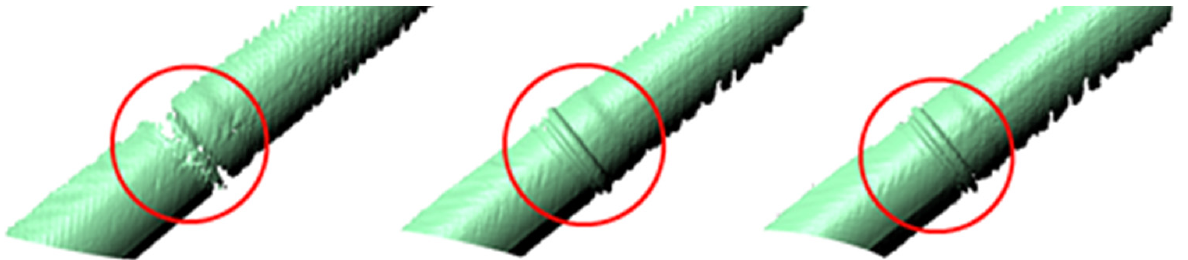
Figure 7. 3D reconstruction result of underwater pipe measurement at 0.7 m/s sensor velocity without motion compensation (MC) ( left ), manual MC ( middle ), and automatic MC ( right ).